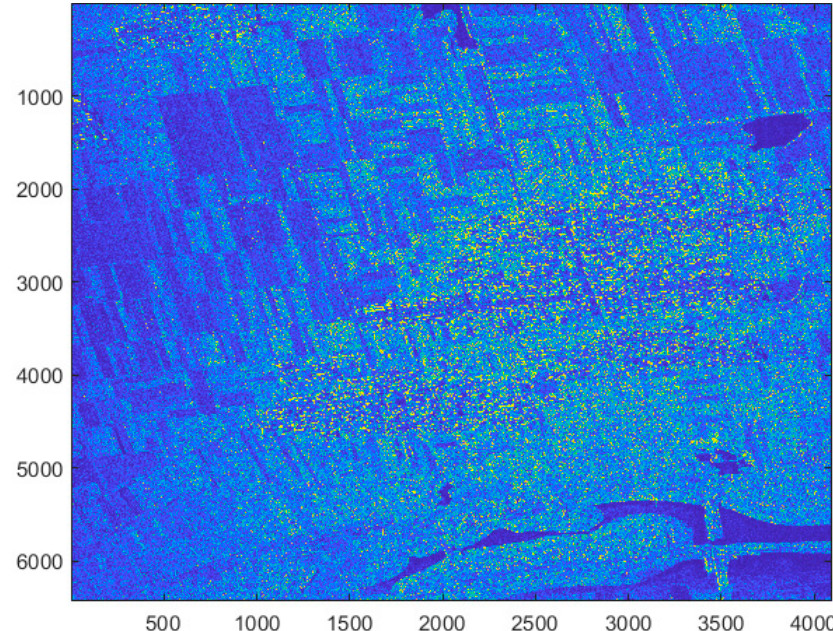
Figure 5. The radar image recovered by the proposed method.